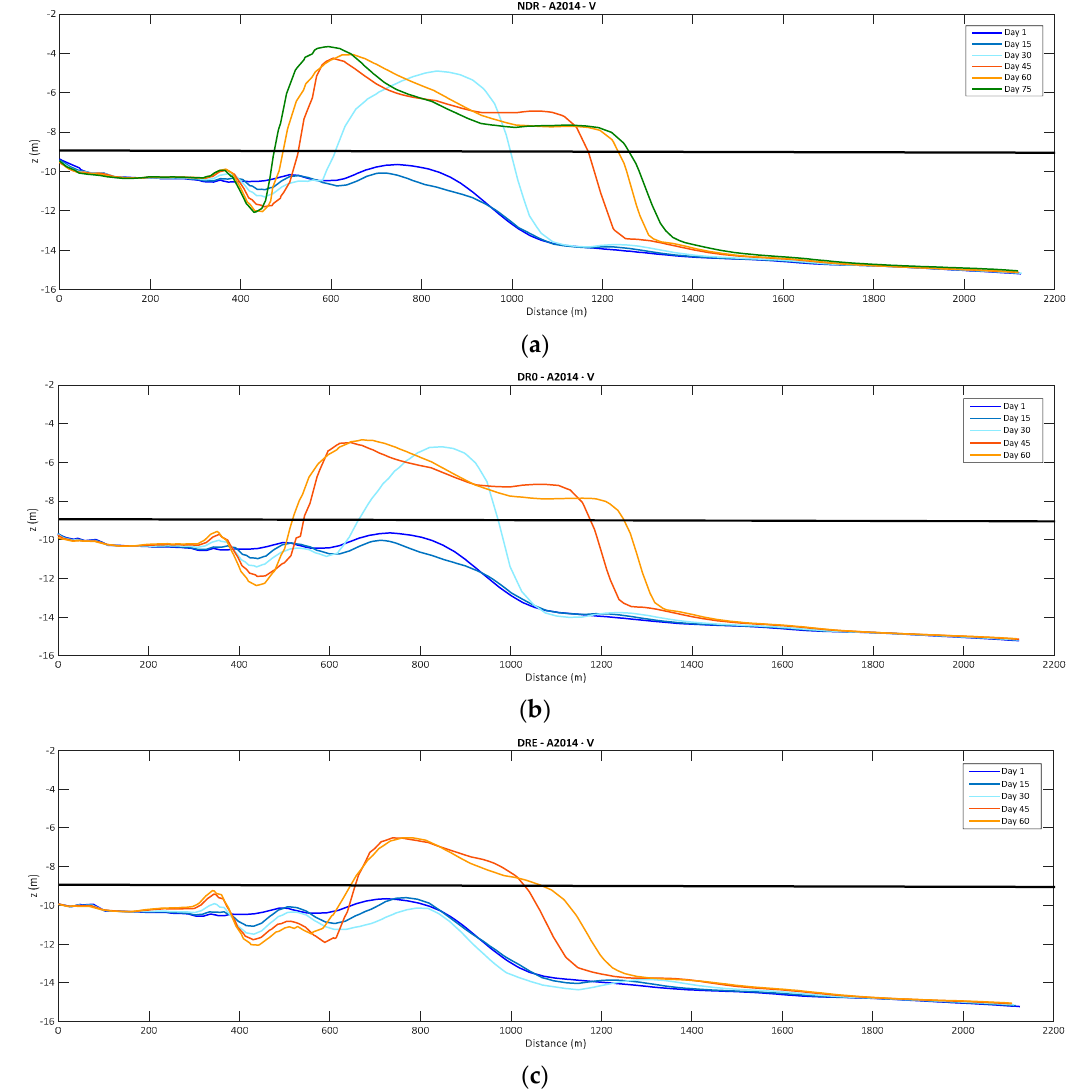
Figure 5. Evolution of bathymetry profile at the tidal inlet mouth depicted with an interval of 15 days under the wave climate scenario of high-energy wave (2014) for ( a ) reference scenario, ( b ) DRO dredging scenario, ( c ) DRE dredging scenario.